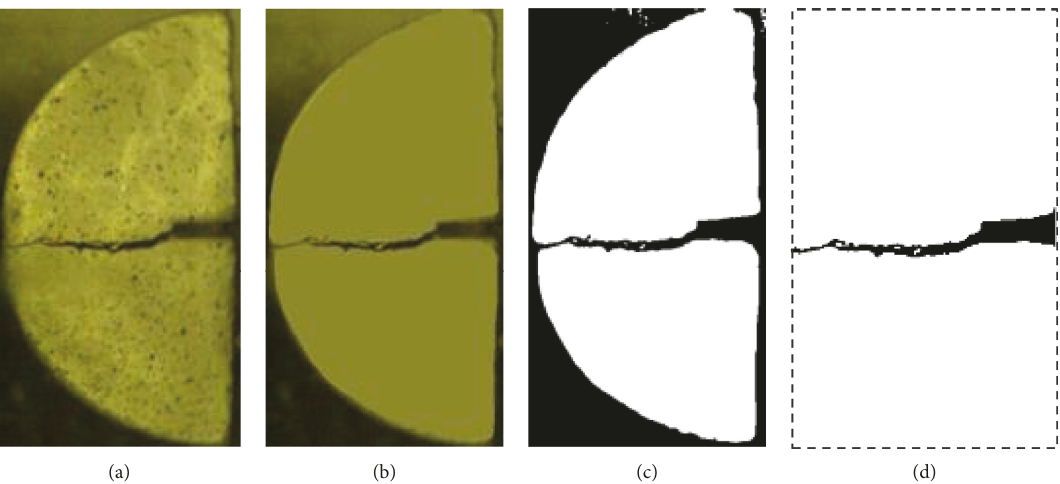
Figure 8: Image processing and crack identification of NSCB specimen: (a) Image of NSCB specimen before loading recorded by high-speed camera, (b) image enhancement based on histogram equalization method, (c) binary image of specimen, (d) extraction of crack path in specimen.